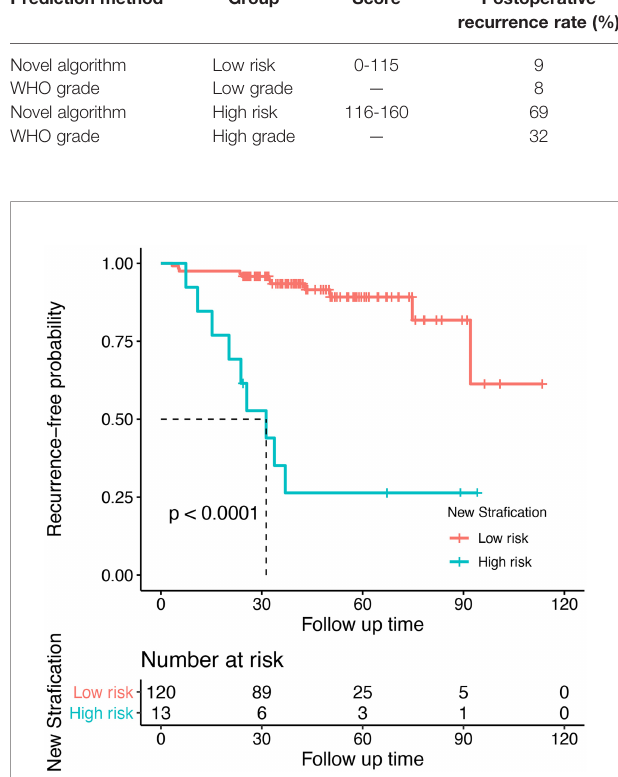
FIGURE 6 | Recurrent risk strati fi cation for patients with meningioma after surgery. Kaplan-Meier curve showed signi fi cant differences in postoperative recurrence between the two groups (P < 0.001).